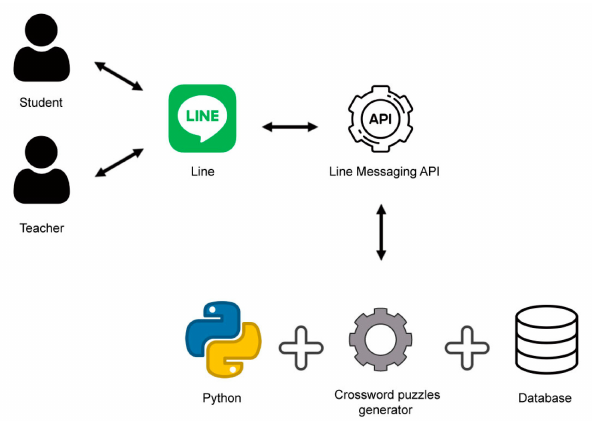
Figure 1. The simplified architecture of Termbot.